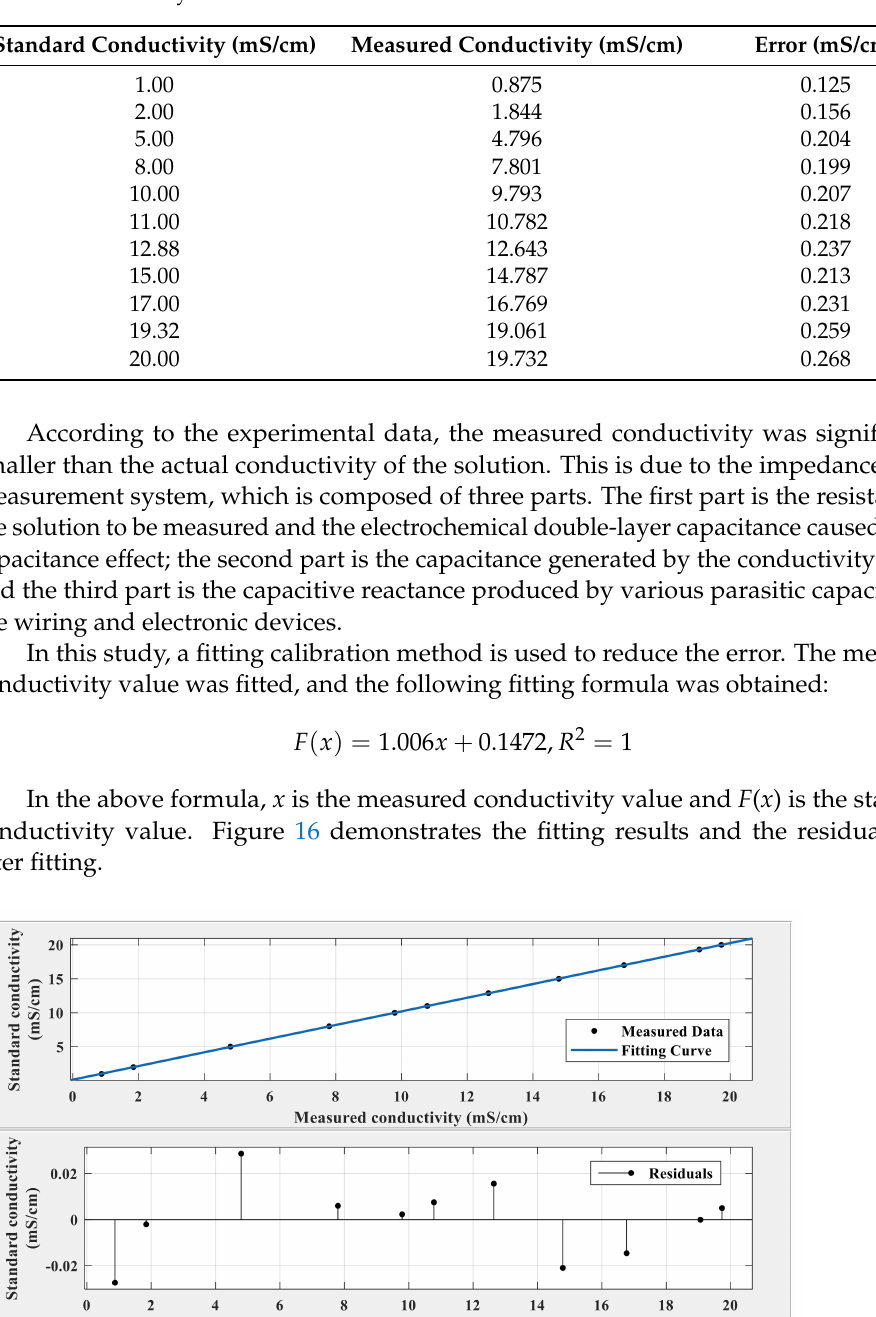
Table 2. Conductivity calibration data.